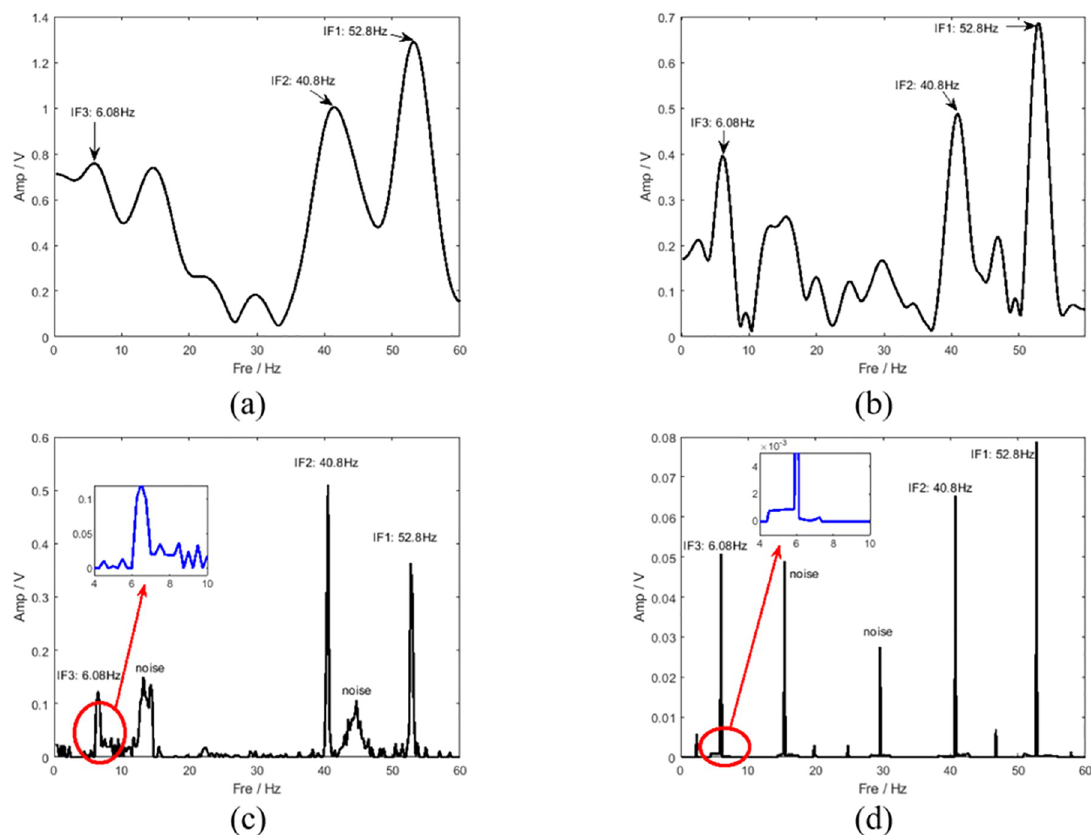
Fig 6. TF slices obtained through (a) STFT, (b) SBCT, (c) RM, and (d) LMSBCT at time t = 0.5 s.